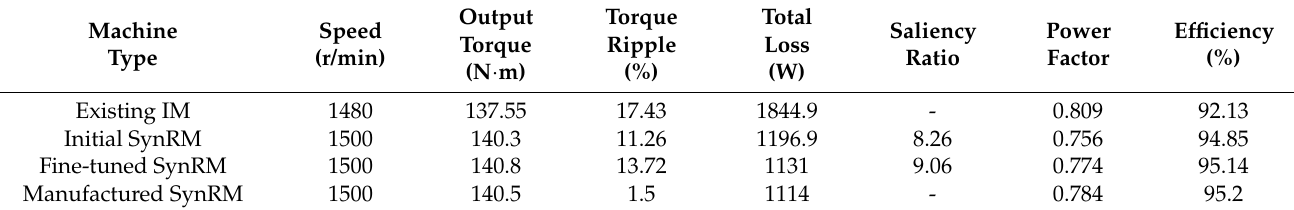
Table 11. Comparison of